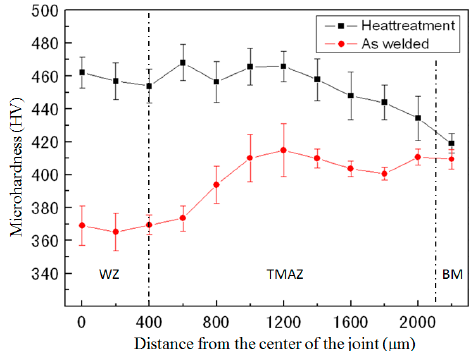
Figure 11. Microhardness of the TC17 LFW joint.